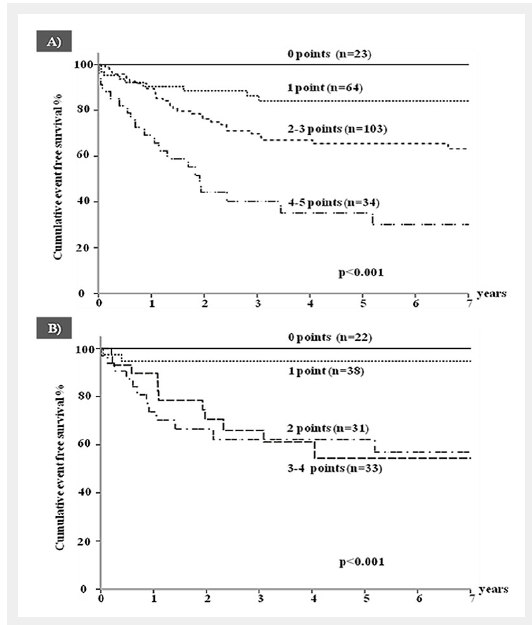
Cumulative event-free survival for a first appropriate implantable cardioverter defibrillator shock according to increasing risk score (M-FACT) in (A) all patients and (B) in patients with no prior aborted cardiac arrest. (Reproduced from reference [40]).